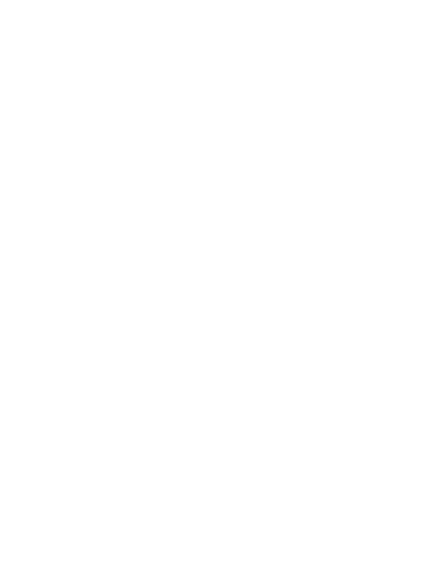
Table 2. Weekly test